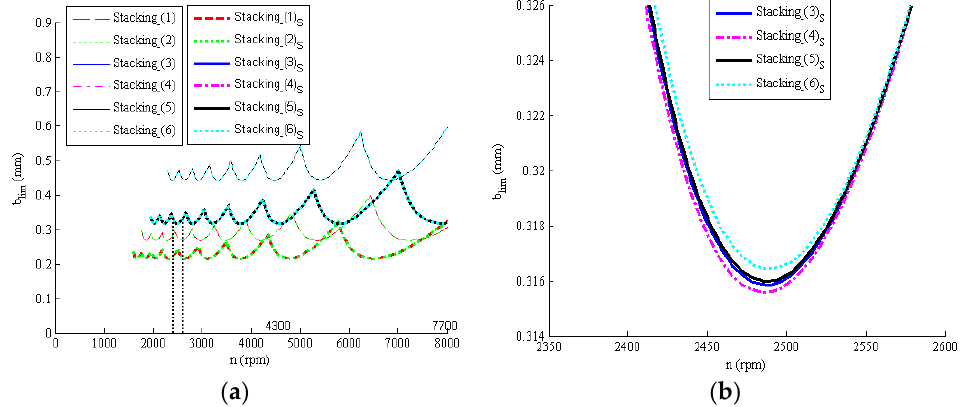
Figure 9. Chatter stability lobes with different stacking sequences. ( a ) Chatter stability lobes of six typical sequences; ( b ) Chatter stability lobes of the latter four sequences. Table 4. Comparison of the ultimate cutting depth of composite boring bars.